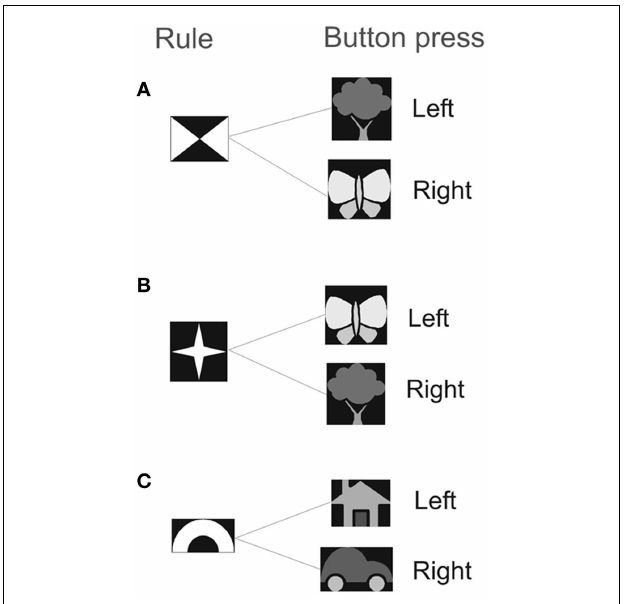
FIGURE 1 |The experiment consisted of two rule types: (A) and (B) indicate the bivalent rule, (C) indicates the univalent rule . Participants viewed the rule cue for 1s. After a 0.5s delay the target stimulus was presented for 2.5s.The response was either a left or a right button press, depending on the relevant mapping that had been previously